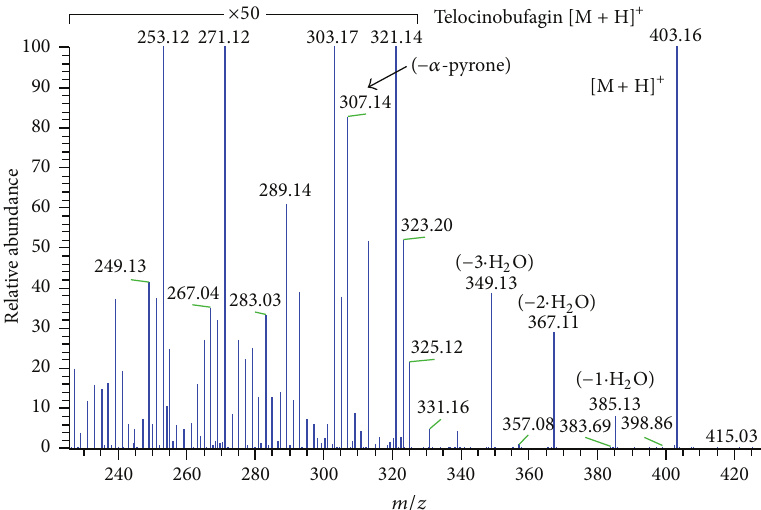
Figure 2: Off-line MS 2 fragmentation pattern of the peak eluting at 24 󸀠 that was purified from R. marina , according to the profile depicted in Figure 1. The molecule could be identified as being telocinobufagin based on the daughter ions and published results.